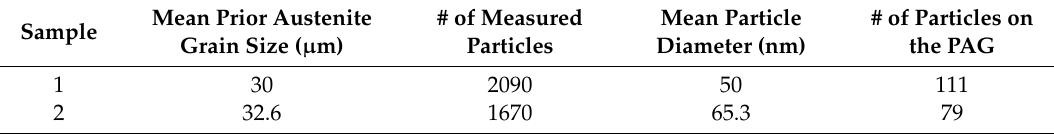
Table 5. Statistical evaluation and comparison of both austenitization